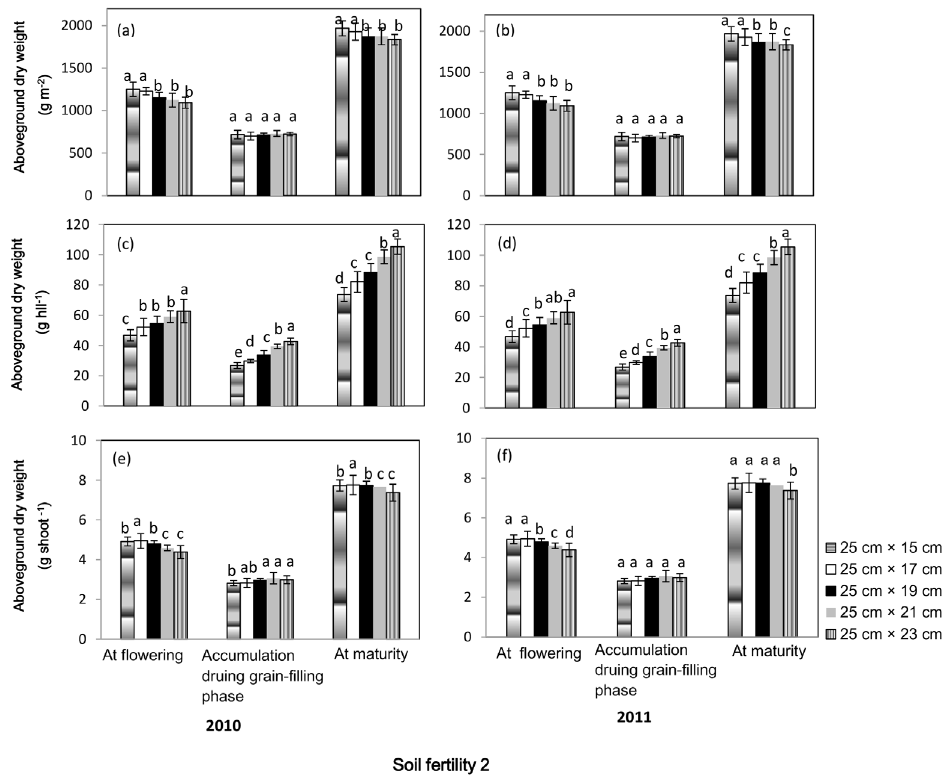
Figure 4. Aboveground dry weight at flowering and maturity, and dry weight accumulation during grain-filling phase of a high- yielding hybrid rice variety Nei2you6 grown at five seeding spacings in soil fertility 2 at the China National Rice Research Institute, Zhejiang Province, China, in 2010 and 2011. Aboveground dry weight was calculated as dry weight per m 2 (a, b), dry weight per hill (c, d), and dry weight per shoot (e, f). Dry weight per shoot was the ratio of dry weight per hill to productive tiller number per